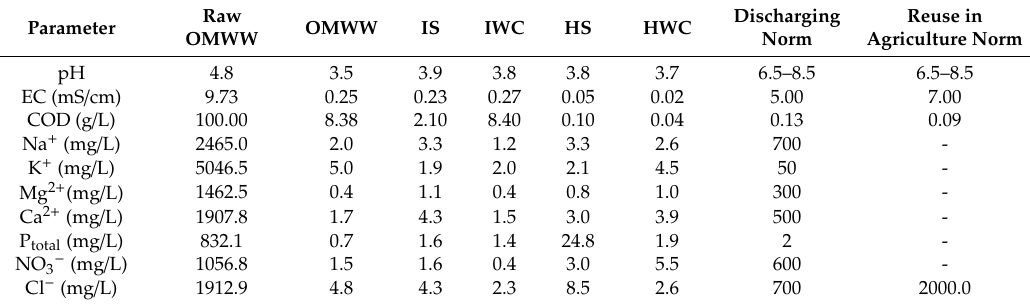
Table 2. Main parameters of raw OMWW and allowable concentrations (standards).